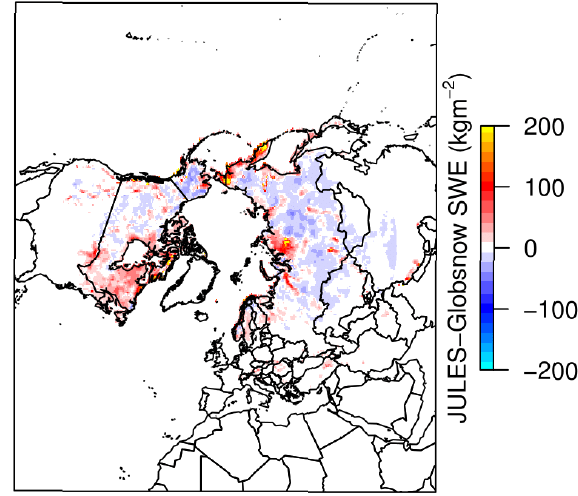
Figure 8. Comparison of Globsnow and JULES. Mean snow wa- ter equivalent (SWE) in Globsnow was subtracted from the JULES values over the same time periods. See Sect.